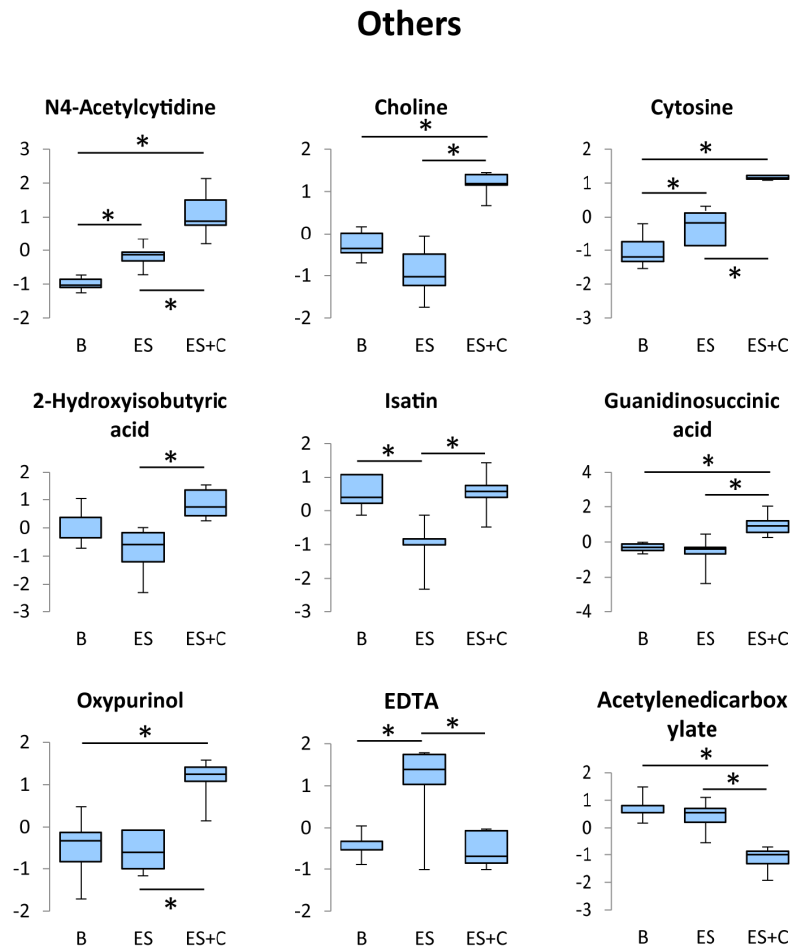
Figure 7. Box plots of the concentration variations of significantly altered metabolites in the other pathways. * One-way ANOVA with Tukey’s post hoc test indicates a significant difference (FDR < 0.05) between groups.